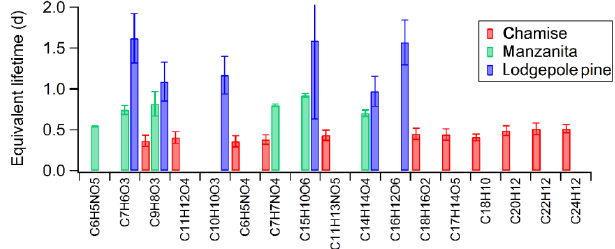
Figure 5. Approximate atmospheric lifetimes for select individual BrC chromophores due to UV irradiation in BBOA from chamise, manzanita, and lodgepole pine fires (the irradiation times are listed in Table S2). These lifetimes are shorter than those calculated for overall BrC